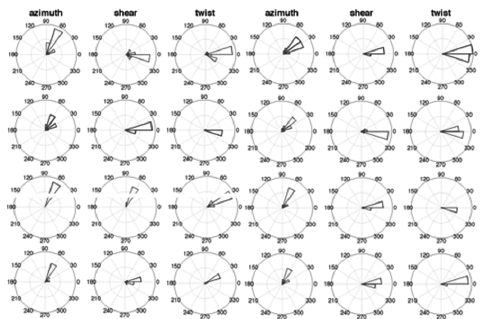
Fig. 5. Rose diagram of the estimated strike direc- tion and of the telluric distortion parameter (shear and twist) for the eight CSAMT sites. Each line cor- responds to a single site. In each diagram different estimates of the parameters, relative to different fre- quencies, are